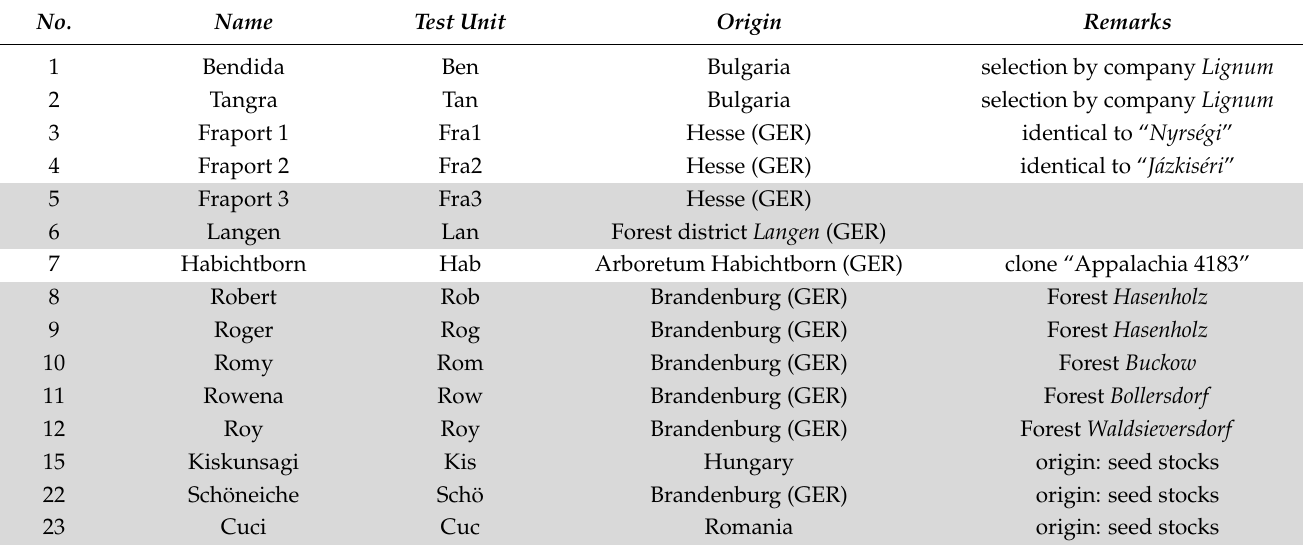
Table 2. Experimental set up for testing different Black Locust clones and provenances. The back- ground colour is highlighting the 10 test units actually investigated in the study (10 of 15 in